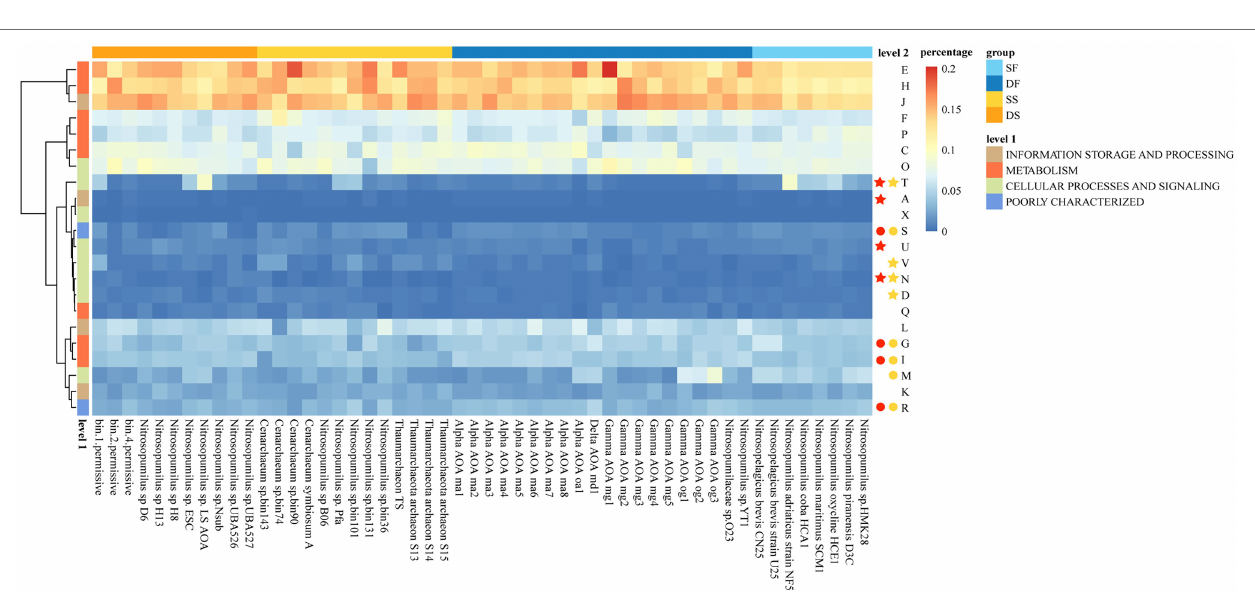
FIGURE 3 | Bar chart and dot plot showing the genome composition of sponge-associated and free-living Thaumarchaeota with >95% completeness. Bar colors represent the location of Thaumarchaeota: Shallow-water sponge (yellow), Deep-sea sponge (orange), Shallow water (light blue), Deep sea (dark blue). Dots indicate the GC content (red) or coding density (blue). CDS, coding sequence and nonCDS, non-coding sequence.